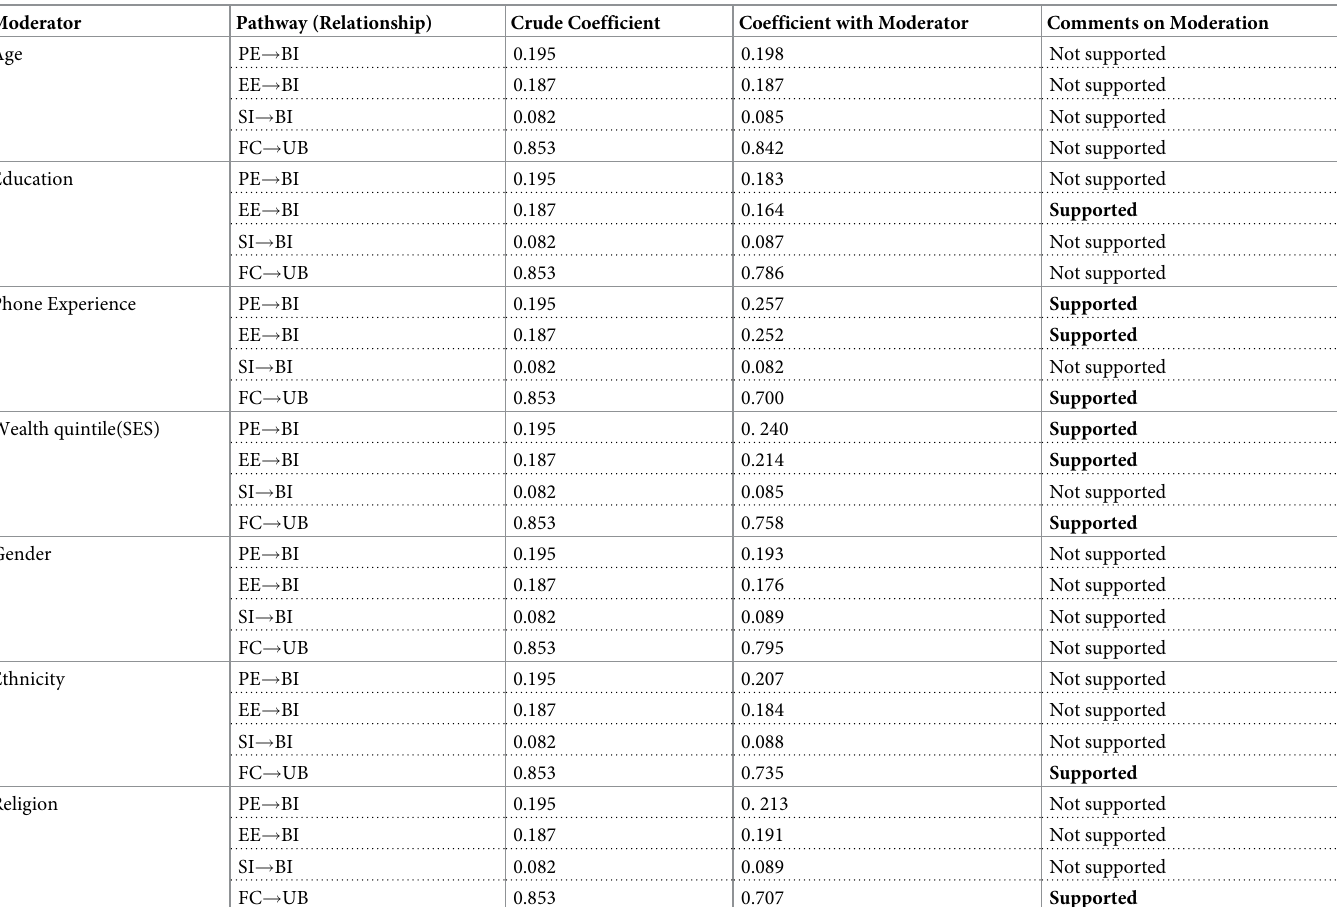
Table 5. The effect of moderators on the association between the independent and dependent